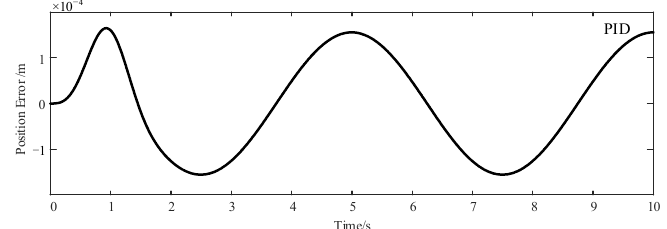
Figure 5. PID Tracking Error of 0.2 Hz Sinusoidal Signal.